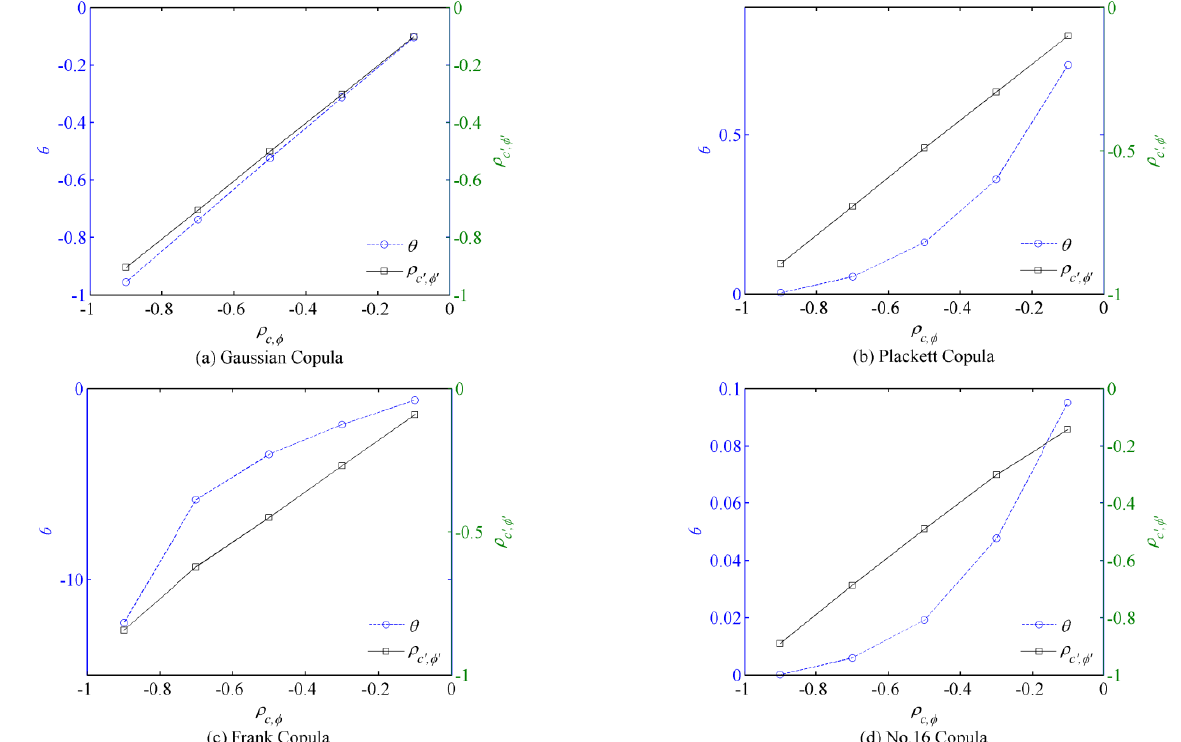
Figure 15. Copula parameters change with the correlation coefficient.